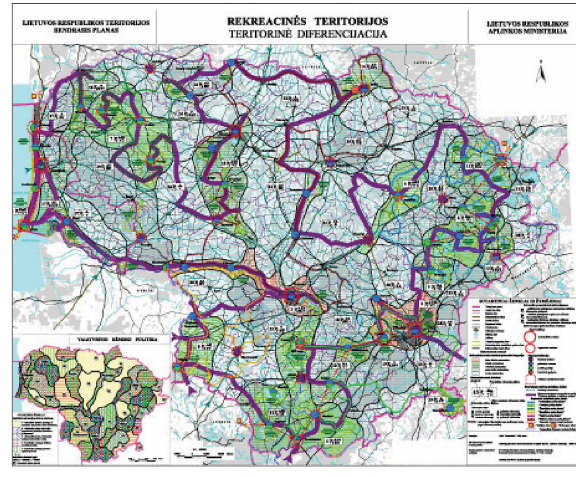
Fig 3. Plan of recreational territories